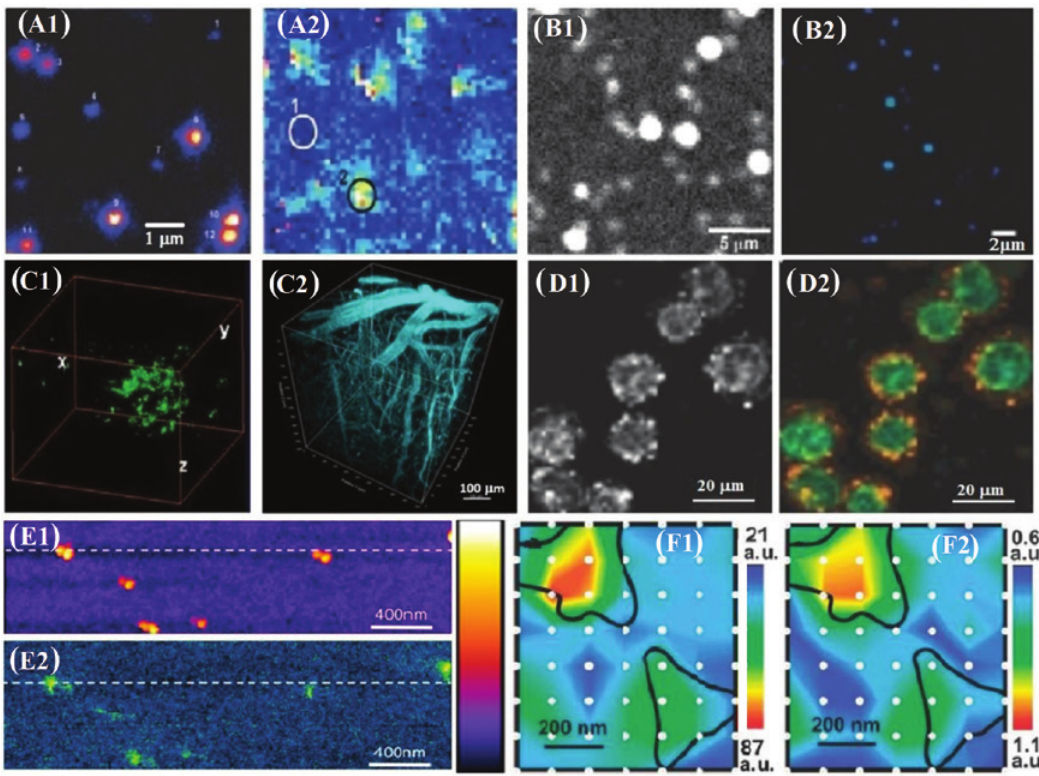
Figure 3: Optical imaging based on inherent nonlinearity of plasmonic nanostructures. (A) SHG map of individual (A1) silver nanoparticles deposited on a coated substrate. Reprinted with permission from ref [124] and (A2) gold nanoparticles dispersed in gelatin. Reprinted with permission from ref [32]. (B) THG images of (B1) individual gold nanoparticles. Reprinted with permission from ref [36], and (B2) 5 nm silver colloids. Reprinted with permission from ref [35]. The very bright dots in (B1) correspond to 100 nm particles, and the rest are 40 nm particles. (C) Nonlinear PL images in tissues. (C1) Three-dimensional 2PL mapping of gold nanoshells in tumor, with field of view of 124 μ m in all three dimensions. Reprinted with permission from ref [125]. (C2) Three-dimensional reconstructed intravital 3PL images of gold nanorod stained mouse brain blood vessels. Reprinted with permission from ref [126]. (D) Two photon microscopy of Karpas-299 cells labeled with gold nanoparticles and H258 dye at the membrane and the nuclear region respectively. The contrasts are based on (D1) intensity, and (D2) fluorescence lifetime. In (D2), the gold nanoparticles (yellow) are clearly distinguishable from the dye (blue-green color) Reprinted with permission from ref [127]. (E) Near-field fluorescence imaging with a gold nano dimer as local- ized FWM photon source. (E1) Topographic image of monodispersed red fluorescent microspheres. The double-lobed feature is due to the dimer antenna. (E2) Simultaneous near-field fluorescence image. Reprinted with permission from ref [128]. (F) Hyperspectral NSOM mapping the nanotriangles, based on (F1) 2PL and (F2) SHG, respectively. Reprinted with permission from ref